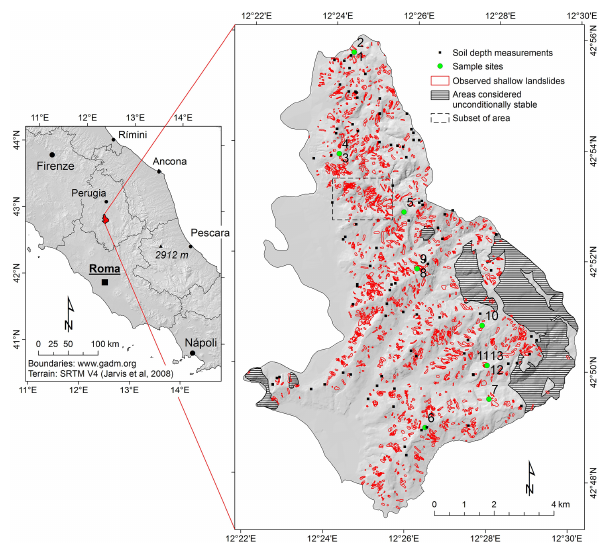
Figure 4. Collazzone study area, Umbria, central Italy. IDs of sam- ple points correspond to IDs listed in Table 2.